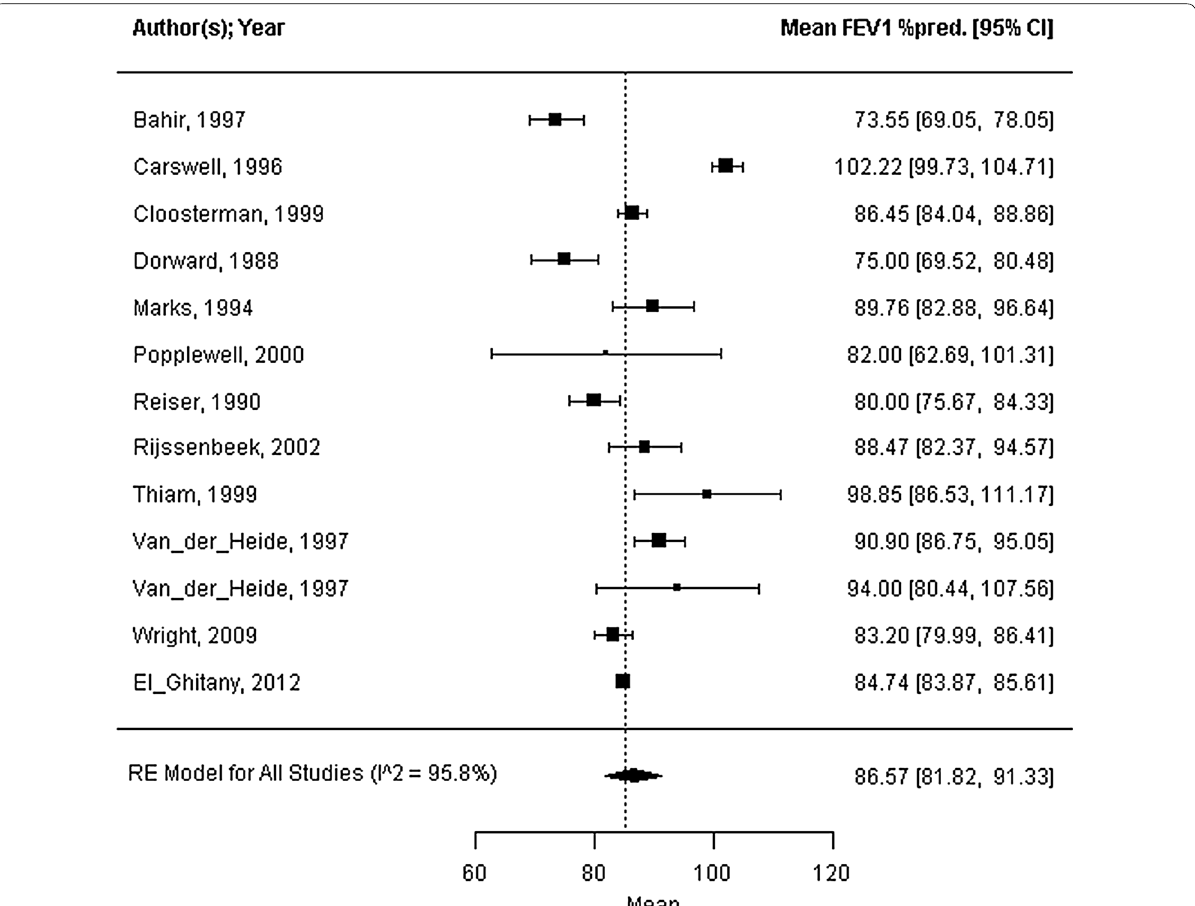
Fig. 4 Forest plot of the FEV 1 percentage of predicted at